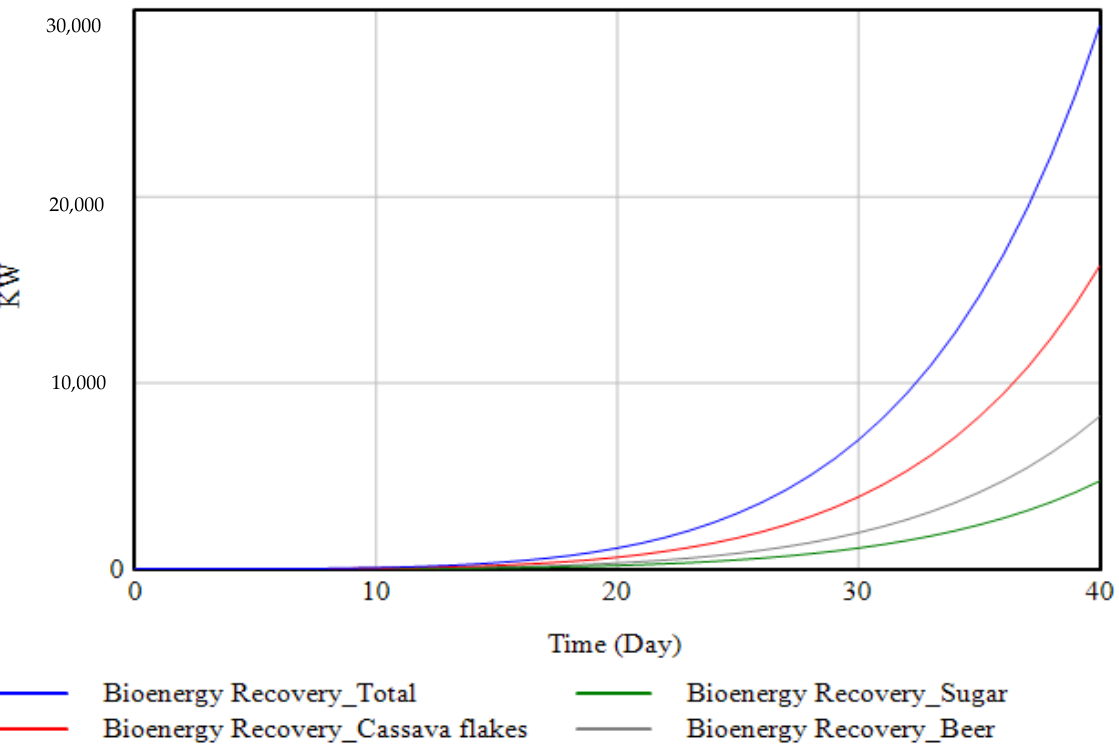
Figure 6. Power generation potential from the effluents produced.